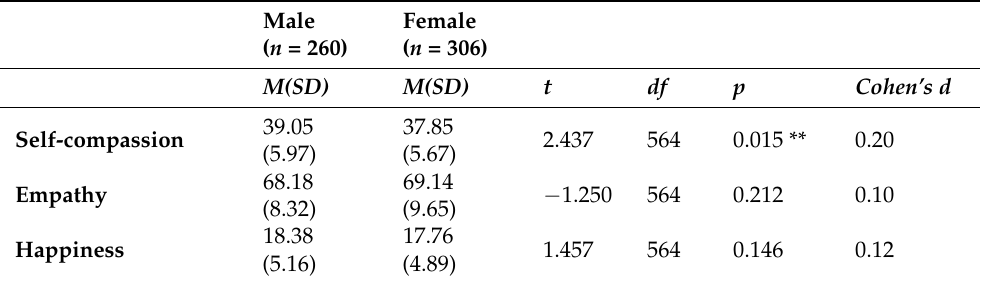
Table 8. Effect of late adolescents’ gender on self-compassion, empathy, and happiness ( N =